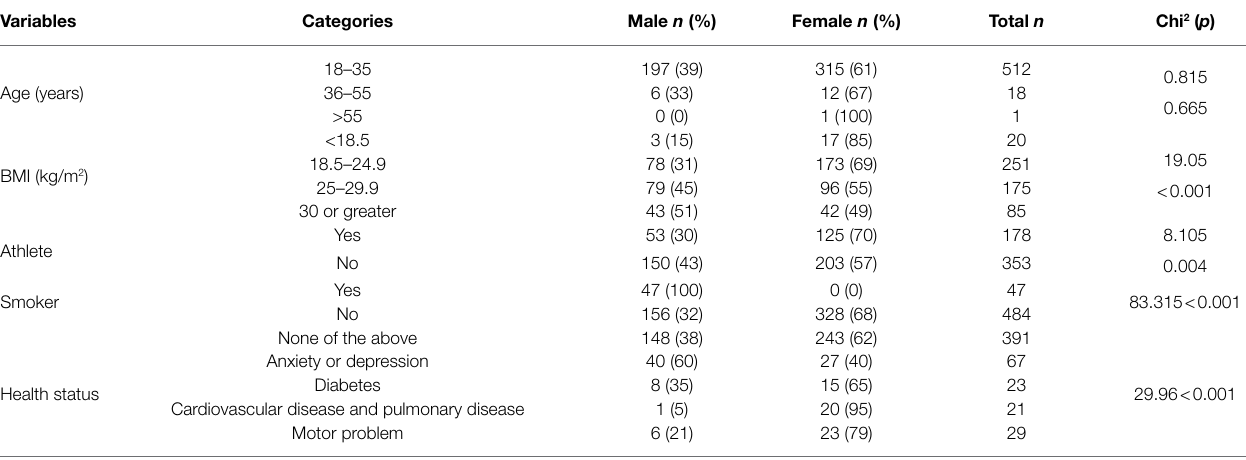
TABLE 2 | Description of the sample (total: n = 531; female: n = 328, male: n = 203) regarding demography, anthropometry, and health status depending on